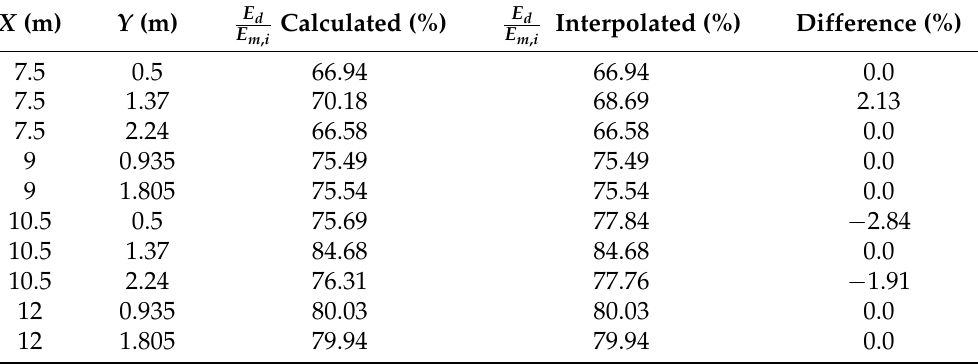
Table 6. Difference (in percentage) between the calculated values and the values obtained by